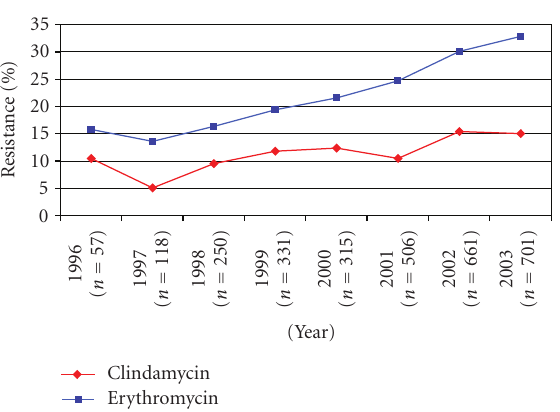
Figure 2: Clindamycin and erythromycin resistance among inva- sive Group B streptococci isolates by state ( n = 2 937 isolates).